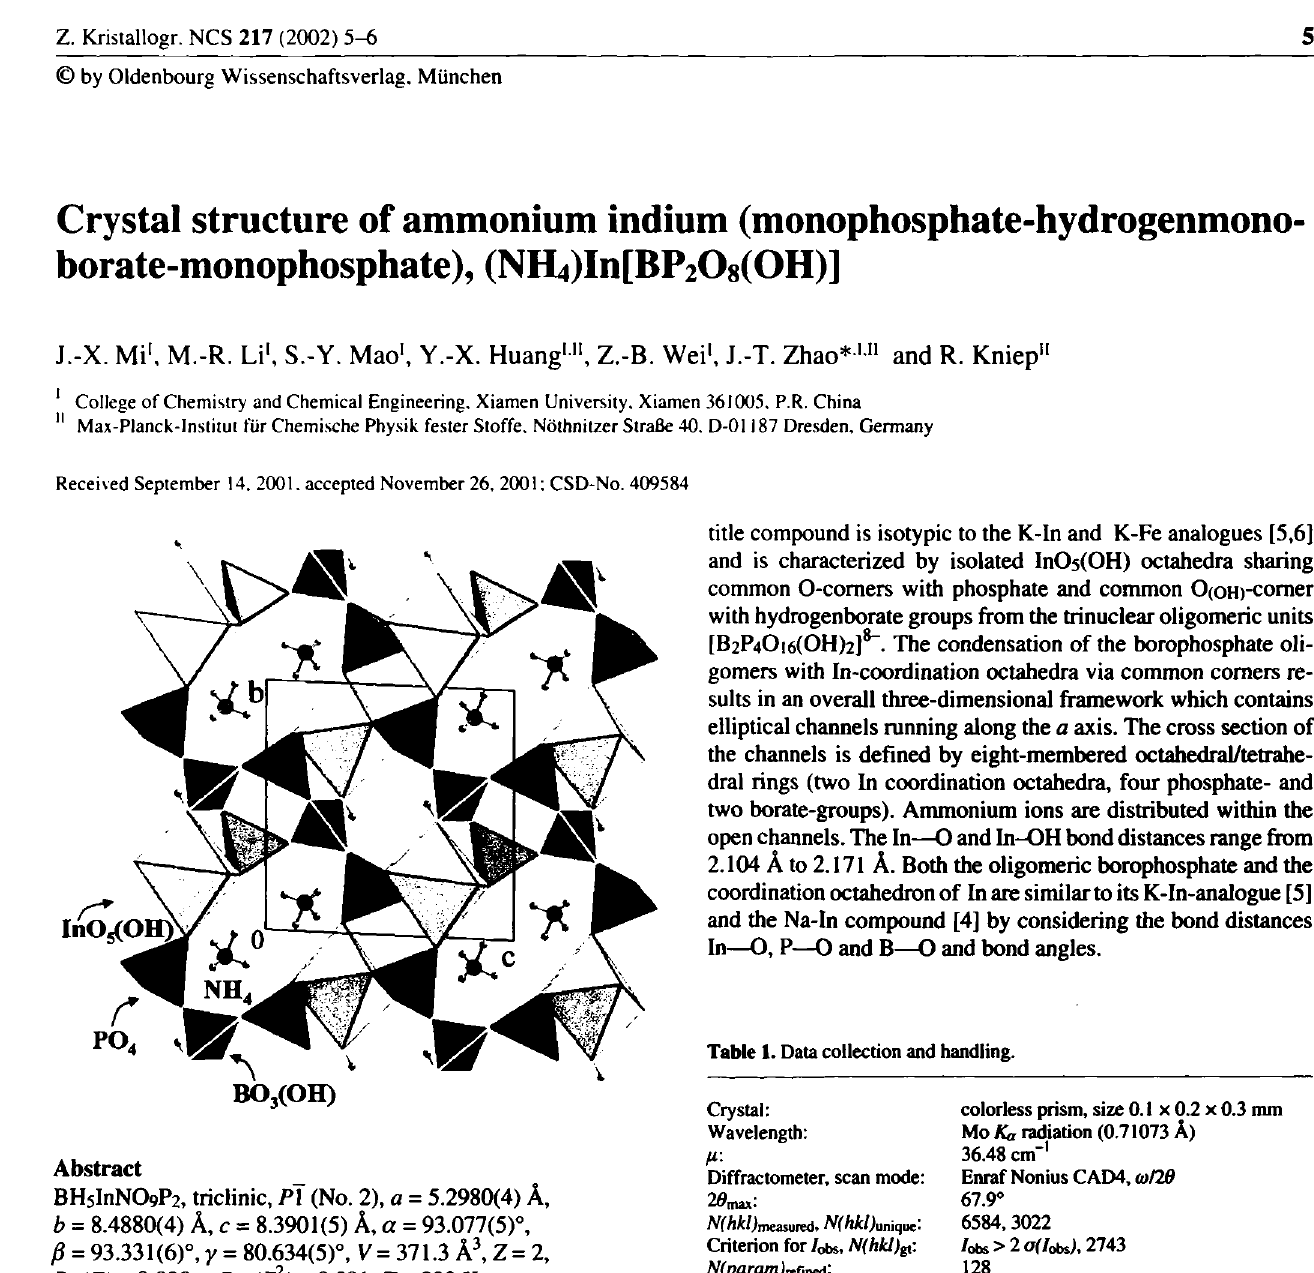
Table 2. Atomic coordinates and displacement parameters (in Â 2